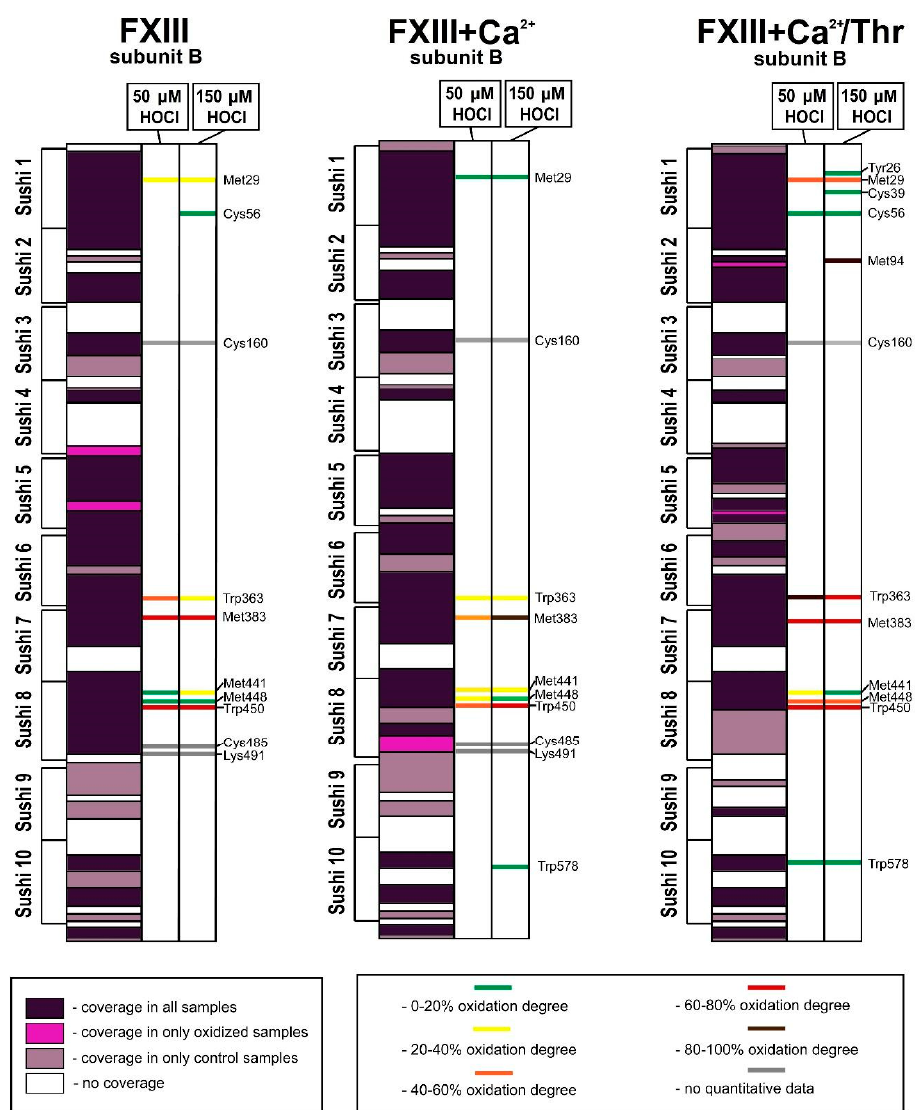
Figure 6. Sequence coverage (left columns) and oxidative modifications in the non-catalytic FXIII-B subunit of the various FXIII samples subjected to 50 μ M (middle columns) and 150 μ M hypochlorite (right columns). FXIII, FXIII + Ca 2+ , and FXIII + Ca 2+ /Thr are the samples of the regulatory FXIII-B subunit in the non-activated FXIII, the FXIII activated only by Ca 2+ , and the FXIII activated by the combined action of Ca 2+ and thrombin, respectively. The label color depends on the overall oxidation degree.